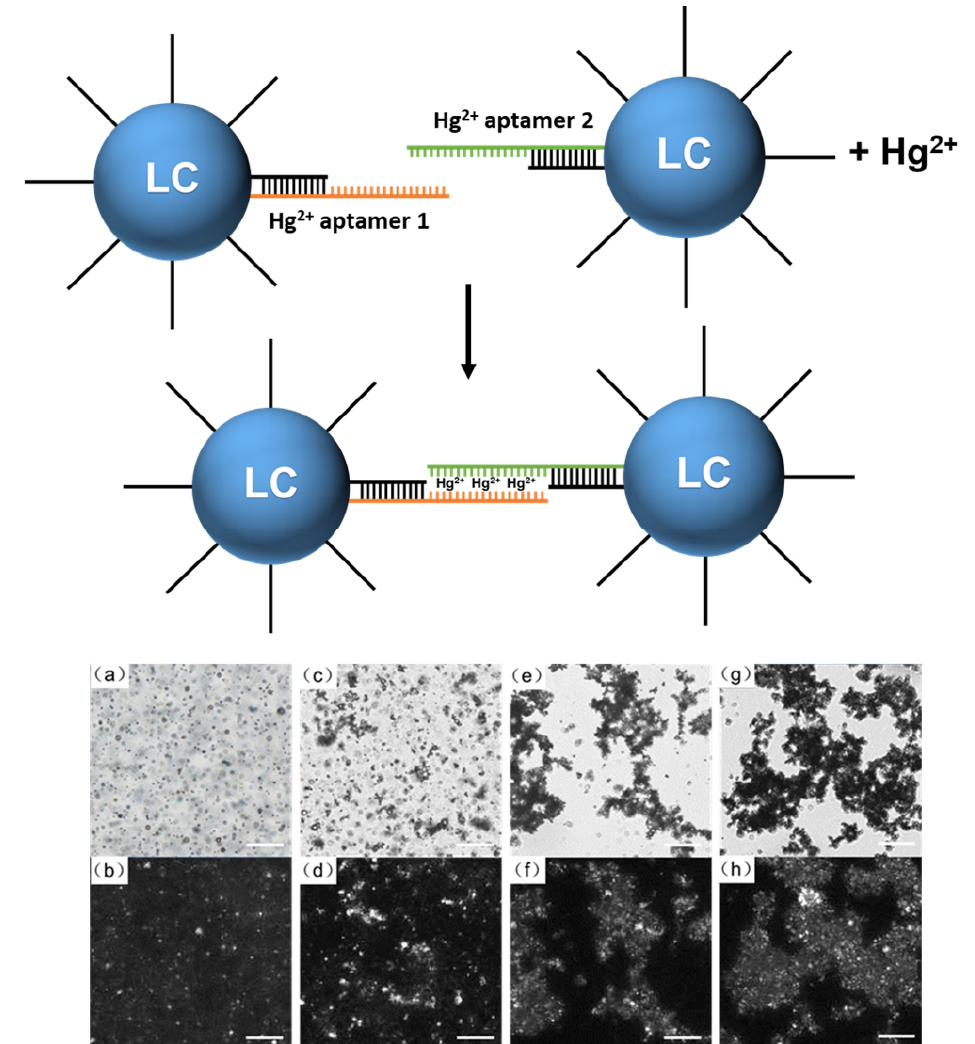
Figure 4. Schematic representation of the responsiveness of DNA ‐ modified LC droplets to Hg 2+ . Optical images of ( a , b ) the DNA ‐ modified LC droplets hybridized with Hg 2+ aptamer 1 and aptamer 2, respectively, and in the presence of ( c , d ) 5 mM Hg 2+ , ( e , f ) 10 mM Hg 2+ , ( g , h ) 15 mM Hg 2+ in bright field ( a , c , e , g ) and polarized field ( b , d , f , h ). Scale bar is 100 µ